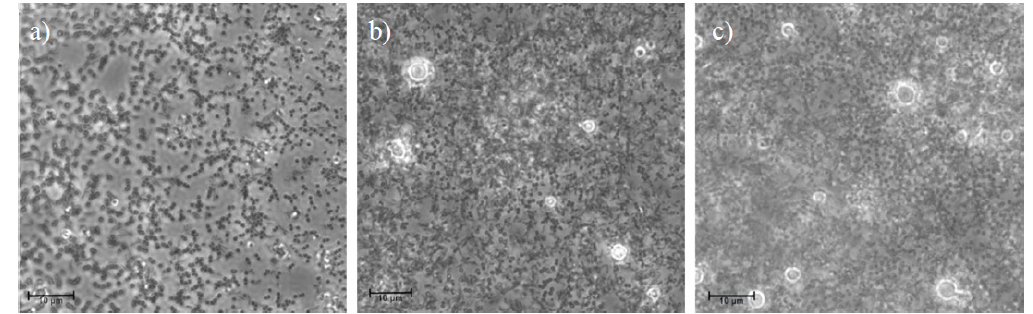
Figure 8. Photomicrographs of the hMoCD14+-PB cells: ( a ) not exposed to CS-NPs (control) and of cells after 24 h of contact with CS-NPs at 50 ( b ) and at 100 µg/mL ( c ) of CS-OA. Scale bar = 10 µm.